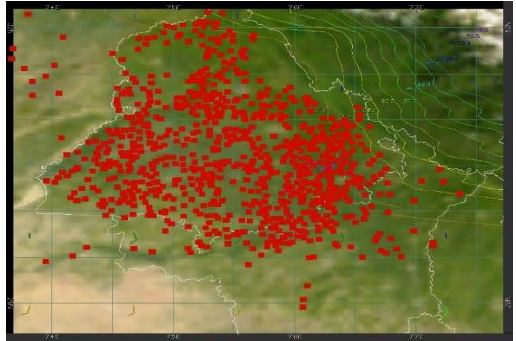
Figure 2. Active fire events detected in Punjab on 26 th October 2016 using AQUA-MODIS (1000m). (Source: CREAMS, IARI)